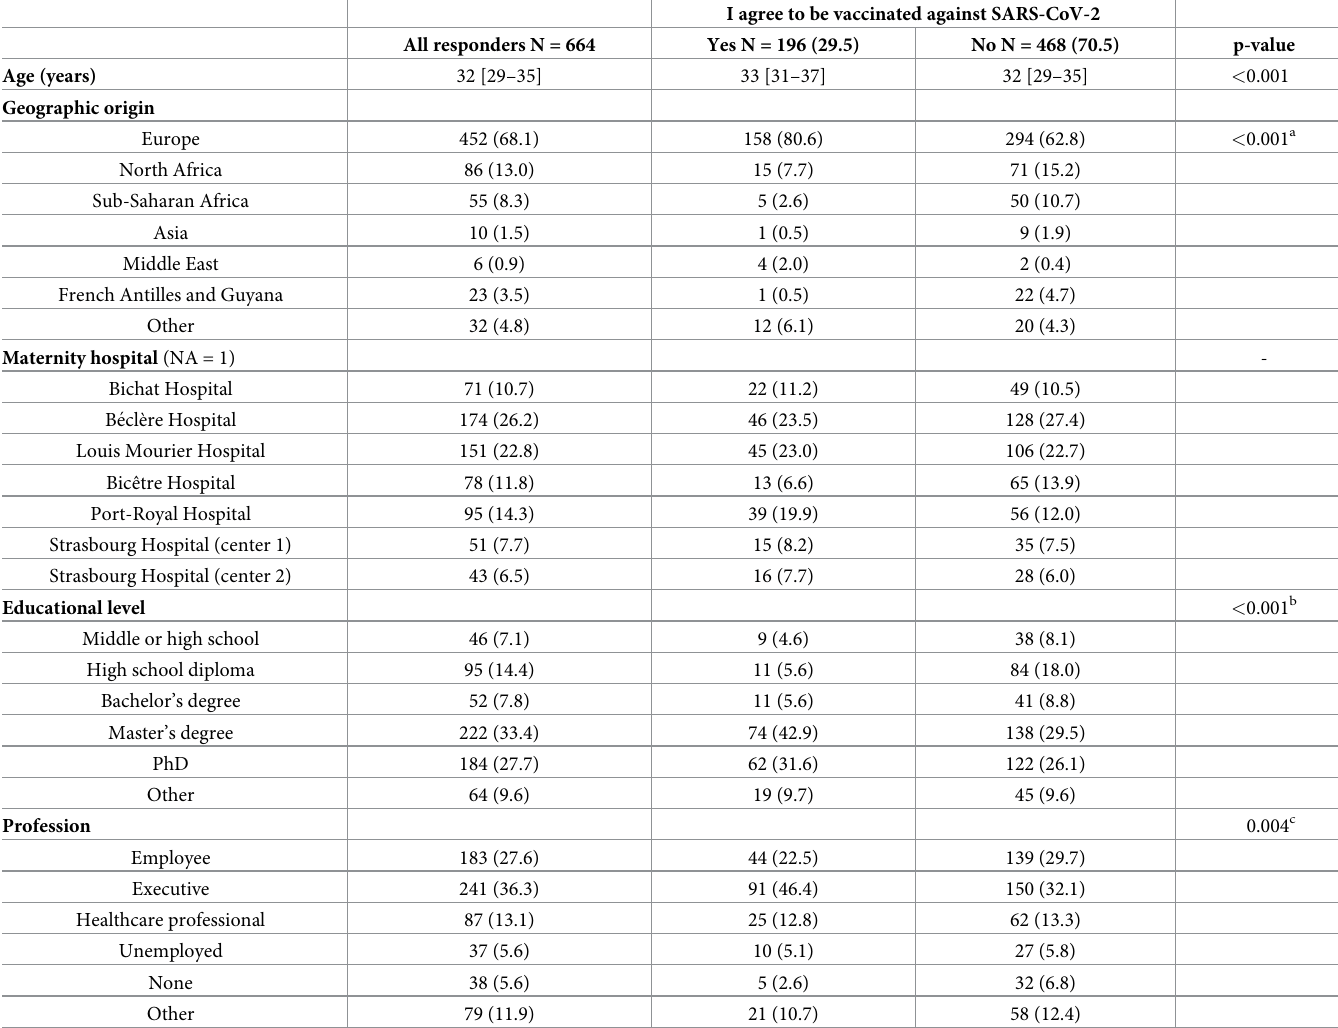
Table 1. Pregnant women’s sociodemographic characteristics and perceptions of the SARS-CoV-2 vaccine. I agree to be vaccinated against SARS-CoV-2 All responders N = 664 Yes N = 196 (29.5) No N = 468 (70.5)